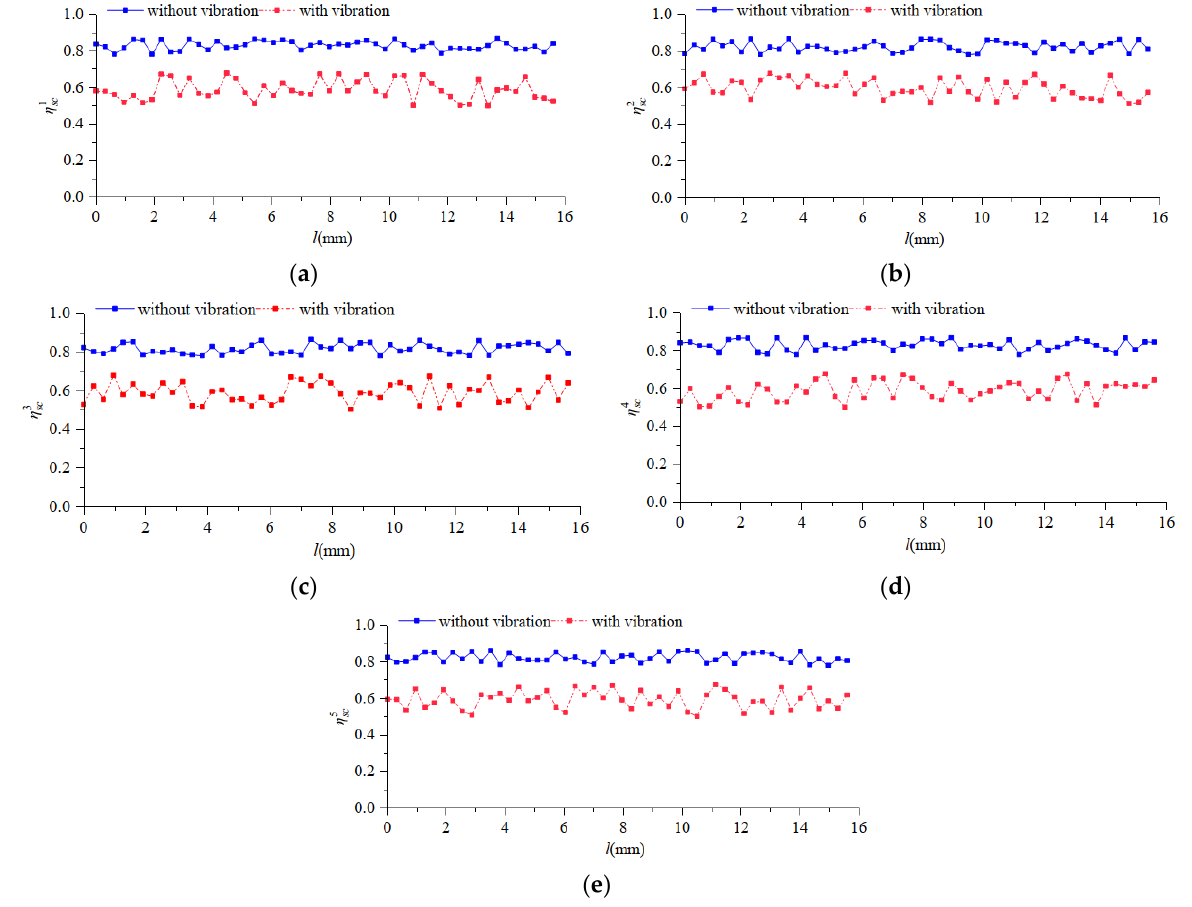
Figure 12. The distribution of instantaneous shear energy efficiency along cutting edge. ( a ) Tooth 1; ( b ) Tooth 2; ( c ) Tooth 3; ( d ) Tooth 4; ( e ) Tooth